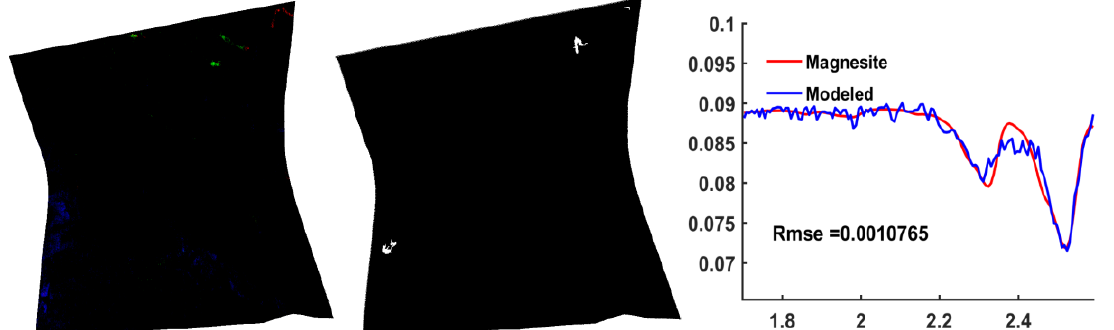
Figure 9. (a) CRISM spectral parameters map (R(MIN2295_2480), G(MIN2345_2537), B(CINDEX)), (b) Our detection map, (c) Modeled spectrum by FATT and magnesite